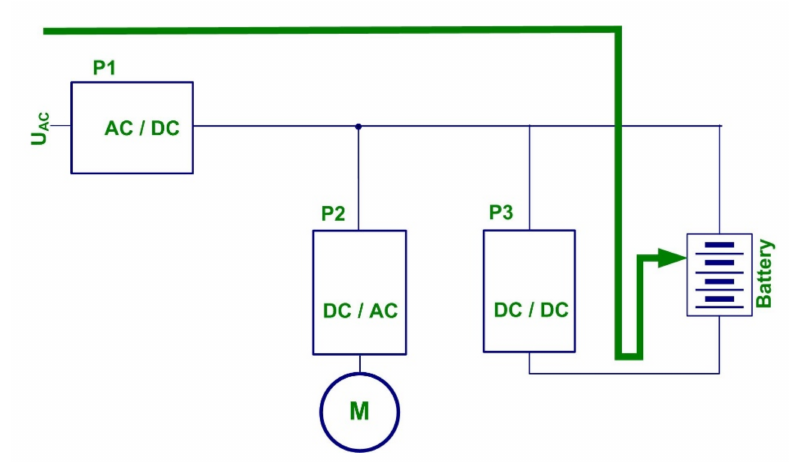
Figure 5. Diagram of power flow during charging of the